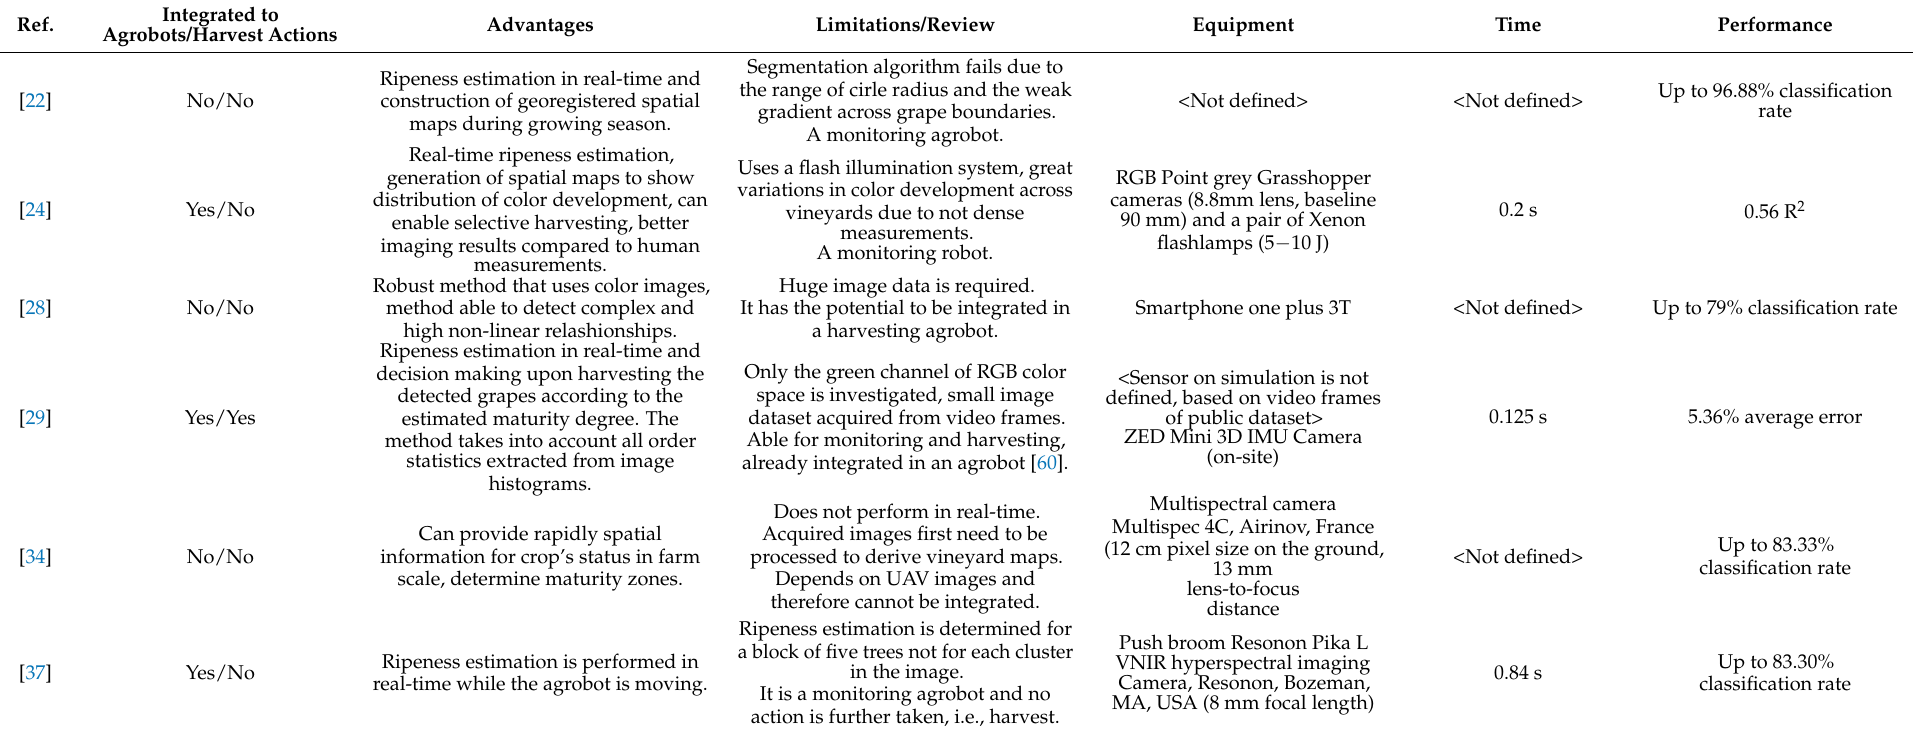
Table 8. Integration ability of intact/on-site applied referenced methodologies to agrobots.